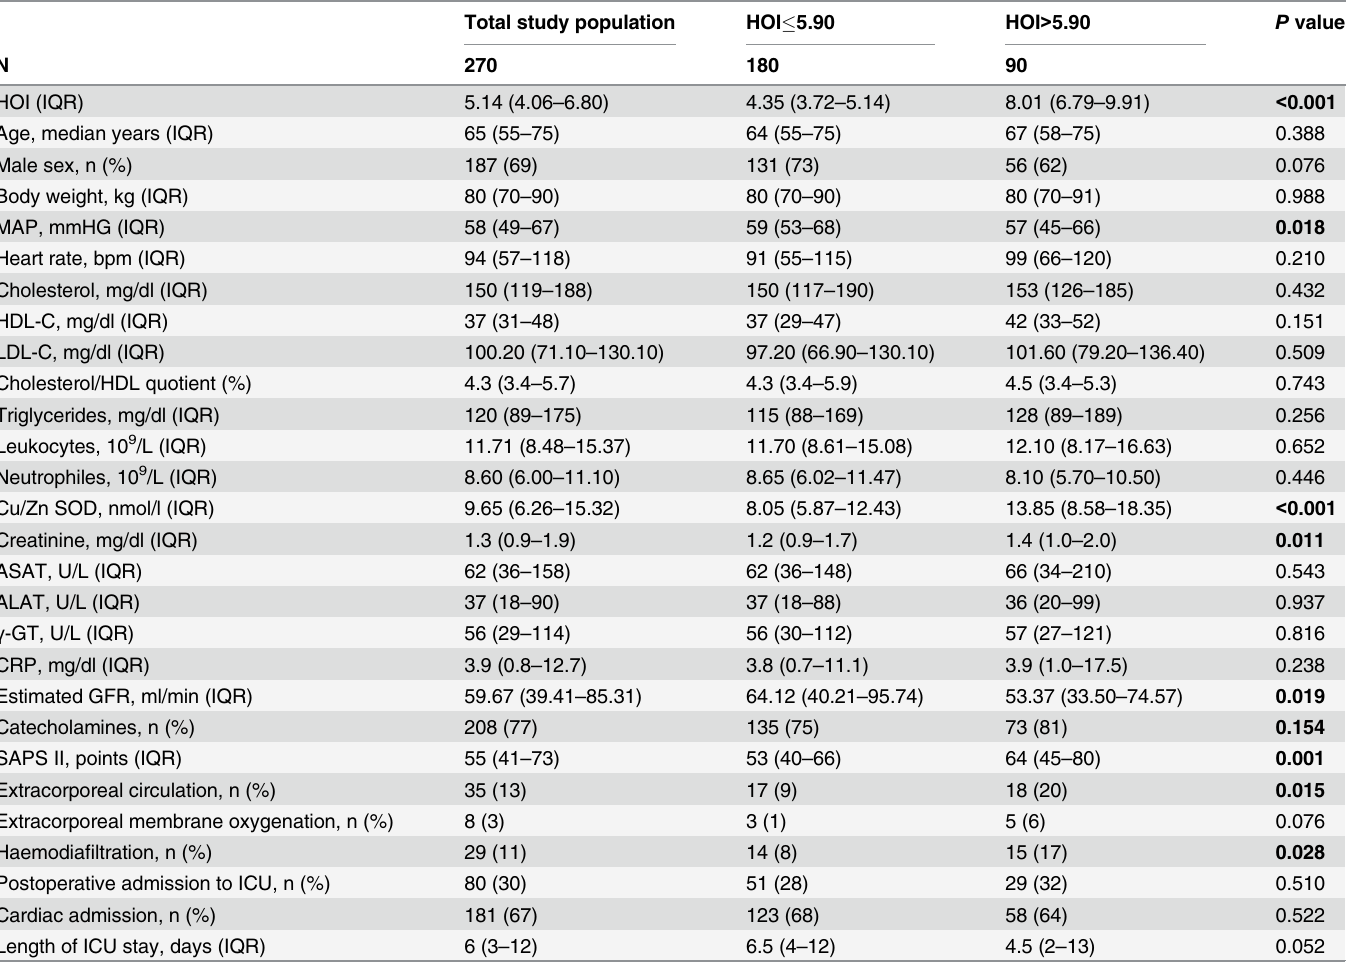
Table 2. Baseline characteristics of total study population and for patients with impaired anti-oxidant HDL function (HDL oxidant index (HOI) > 5.90) and the residual study population (HOI (cid:1)